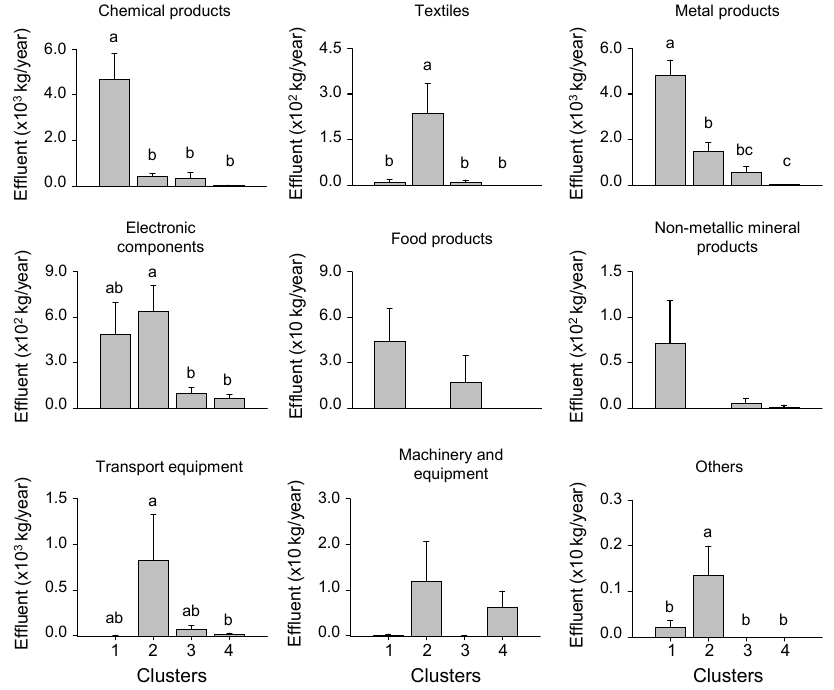
Figure 7. Differences in effluent of heavy metals for each industry types among the four clusters defined by the SOM. Different letters indicate significant differences between the clusters based on Dunn’s test after a Kruskal–Wallis test ( p < 0.05). Error bars indicate standard